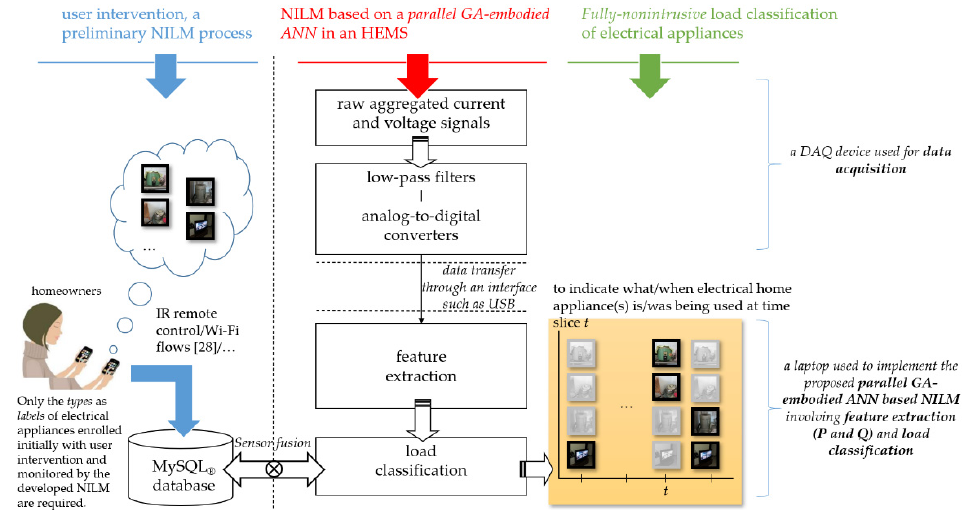
Figure Figure 2. Workflow of the non-intrusive load monitoring (NILM) using a parallel genetic algorithm (GA)-embodied Artificial Neural Networks (ANN) for NILM in this work. The NILM is fully- nonintrusive that no instrumentation for (rated) power consumption on electrical appliances is required during the preliminary stage of the NILM involving the training process of the ANN for load classification.